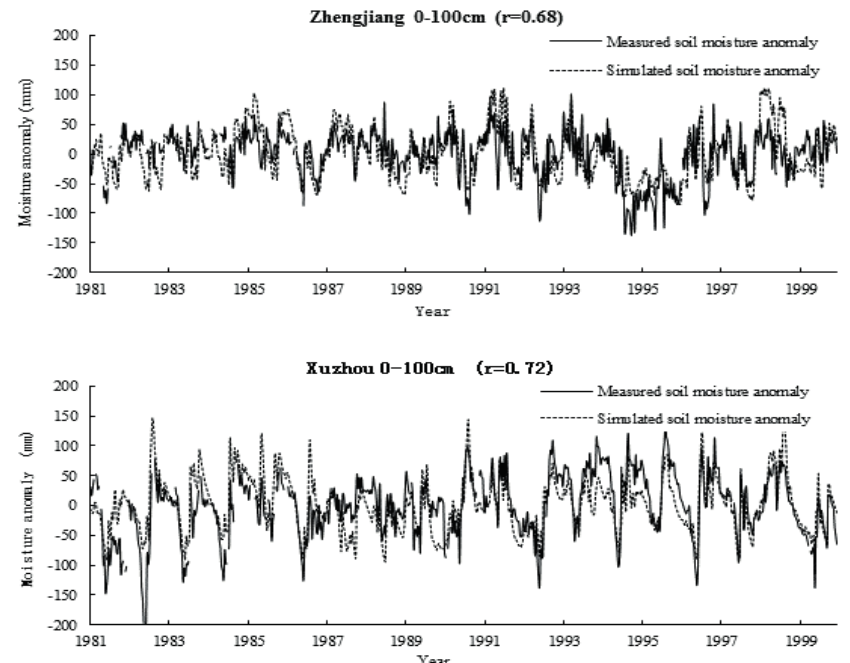
Fig. 3 Comparison of simulated (dashed) and measured (solid) soil moisture anomalies (mm) for 0−100 cm depth at Zhenjiang and